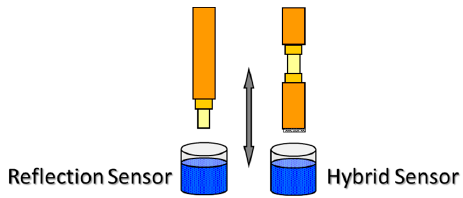
Figure 9. Sensing configurations applicable for dip coating.